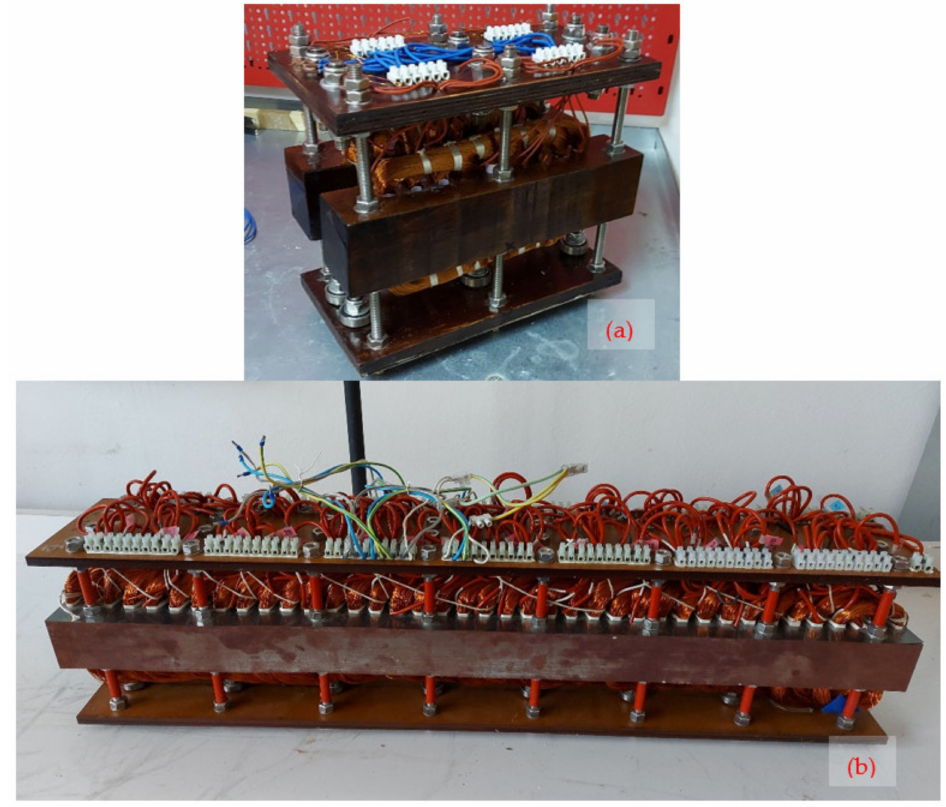
Figure 1. Prototypes of linear generator: ( a ) Ironless machine; ( b ) Iron